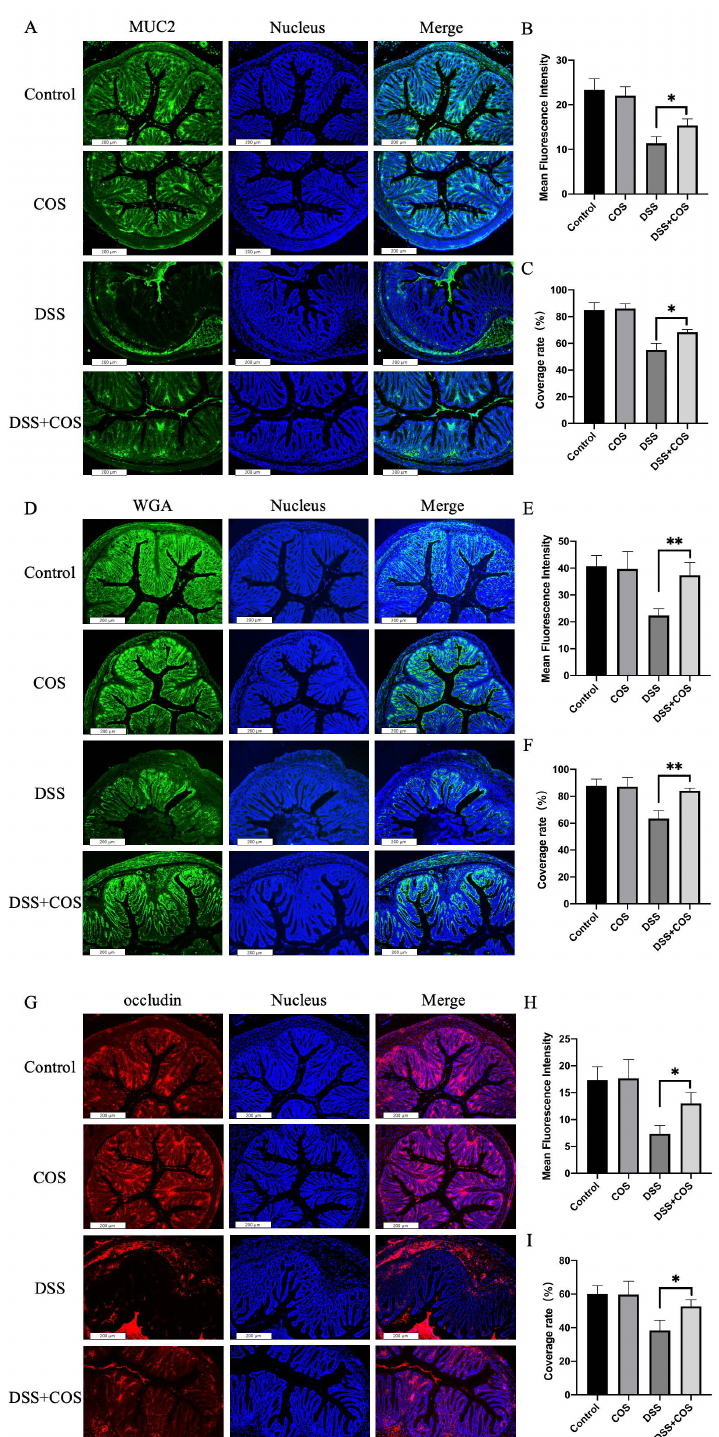
Figure 7. Treatment with COS restored the intestinal barrier damage of DSS-induced colitis. Im- munofluorescence views of MUC2 (green) ( A ), FITC-WGA (green) ( D ), and occludin (red) ( G ) in intestinal tissue; computerized quantification of the mean fluorescence intensity and the coverage rate of MUC2 ( B , C ), FITC-WGA ( E , F ), and occludin ( H , I ) was performed. The average value of randomly taken images were calculated ( n = 9; * p < 0.05, ** p < 0.01). Error bar represents the standard deviation. Images represent the typical situation of three independent experiments. Scale bars, 200 µ